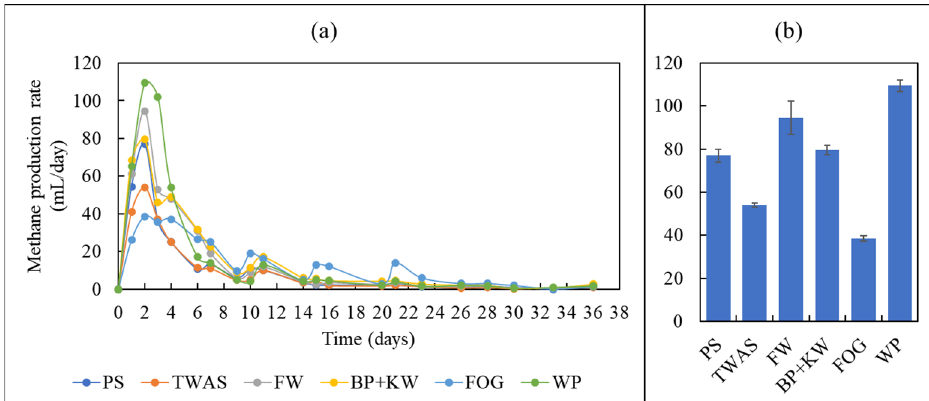
Figure 5. Plots of methane production rates for the different substrates: ( a ) methane production rate (mL CH4/day); ( b ) maximum methane production rate (mL CH4/day).